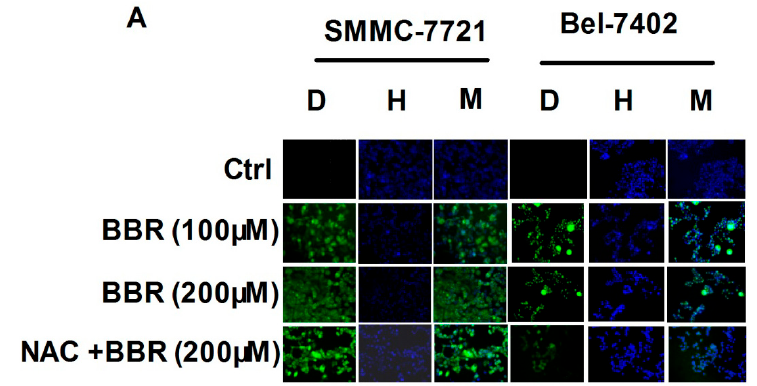
Figure 2. Cont. Figure 1. Cont